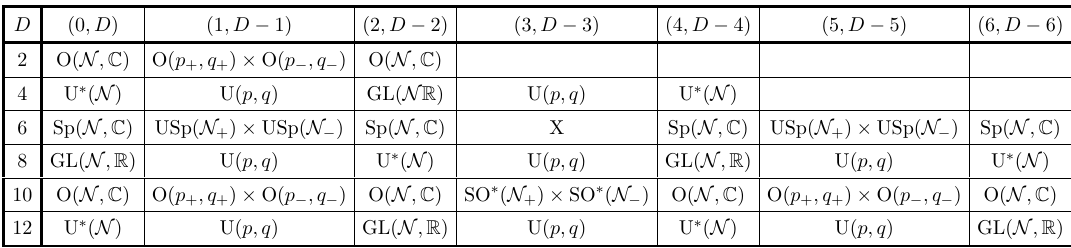
Table 9. R-symmetry groups possible in even dimension with any signature. Note that p + + q + = N + , p − + q − = N − and N + + N − = 2 N . X = (Sp( N + , R ) or USp(2 r + , 2 s + ) ) × ( Sp( N − , R ) or USp(2 r 2 s ) − , −